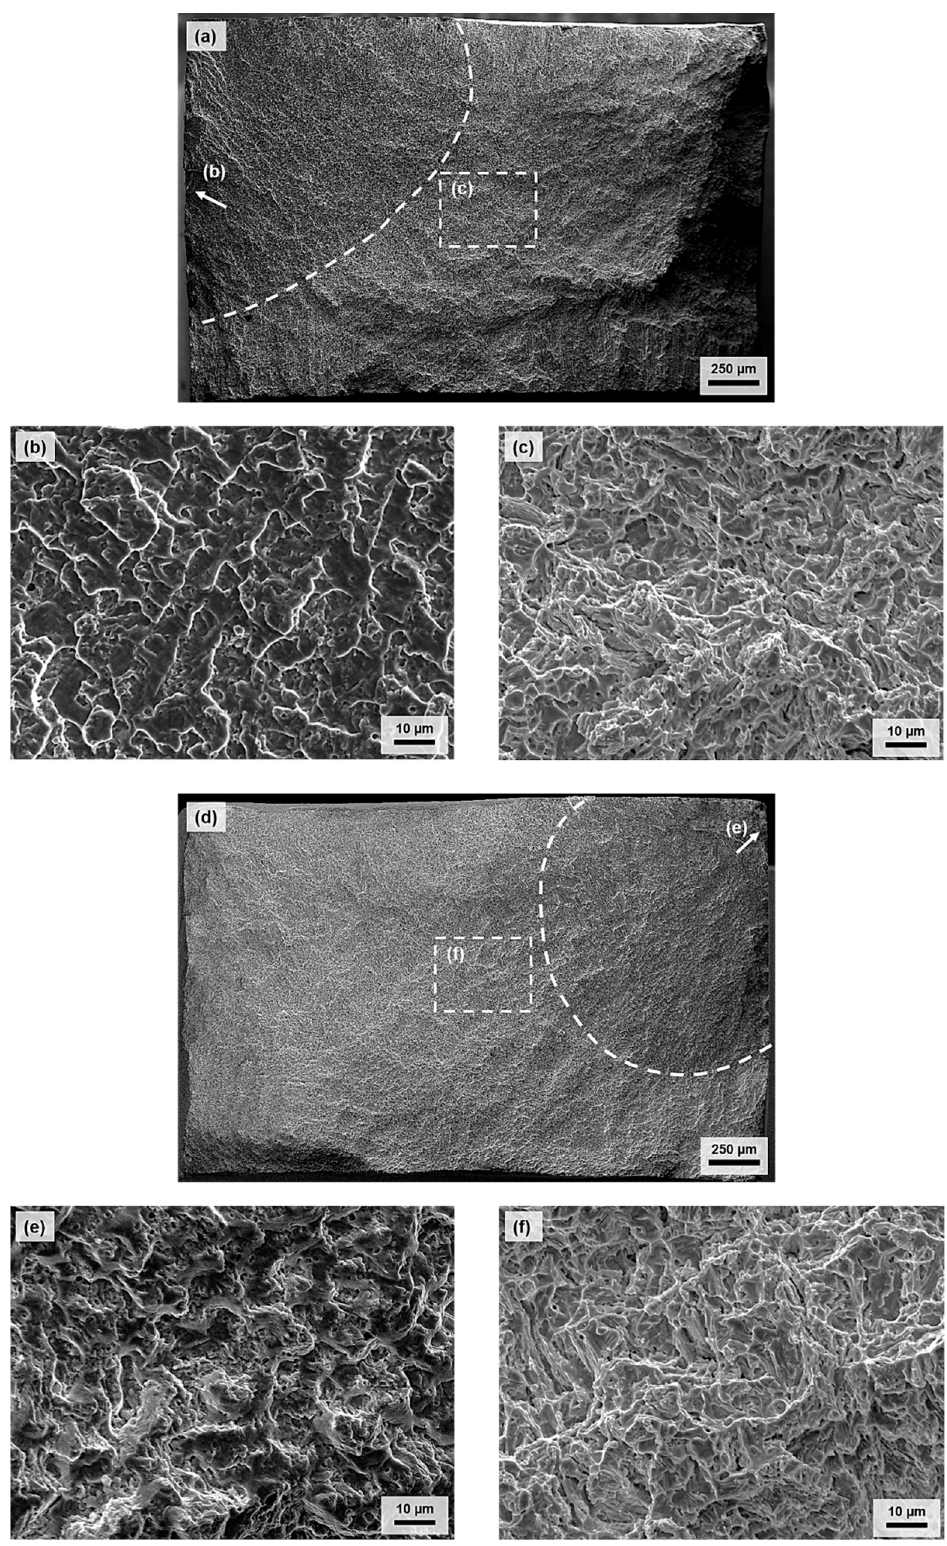
Figure 11. SEM micrographs of fracture surfaces after fatigue testing at a total strain amplitude of Δε t /2 = ±0.5% for the DED SS 316L in ( a – c ) as-built and ( d – f ) SMAT processed conditions. The subimages ( b , c ) and ( e , f ) show magnified views of the areas marked in ( a , d ) with a white arrow and white dashed rectangle, respectively.